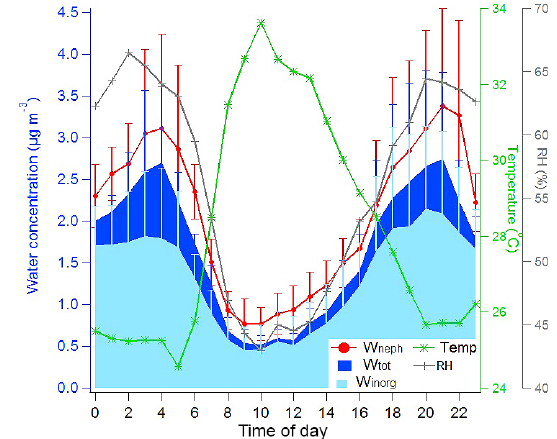
Figure 3. Correlation between calculated and measured LWC of aerosol. Figure 4. Diurnal profiles of predicted and measured water, along with measured RH and T . Average hourly averages and standard deviations plotted as error bars in local time are